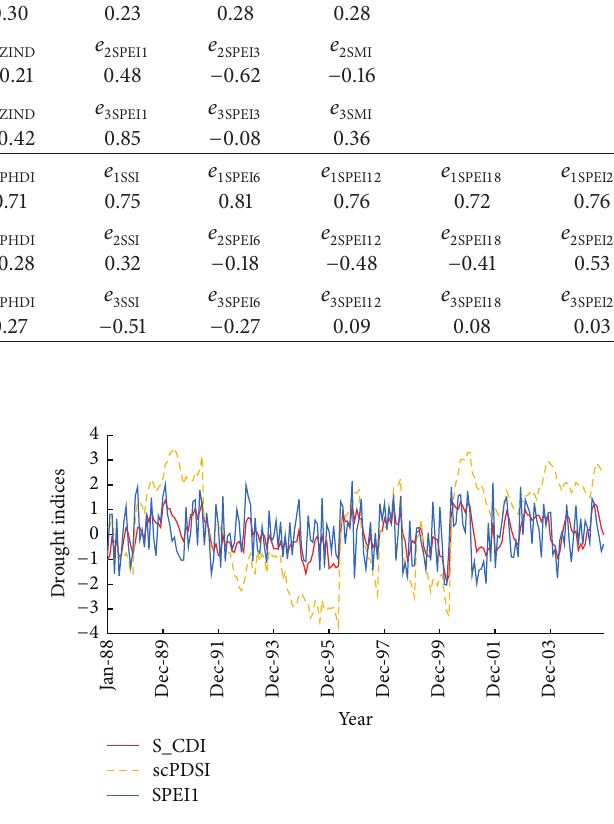
Figure 3: Temporal variations of the short-term CDI and its components.